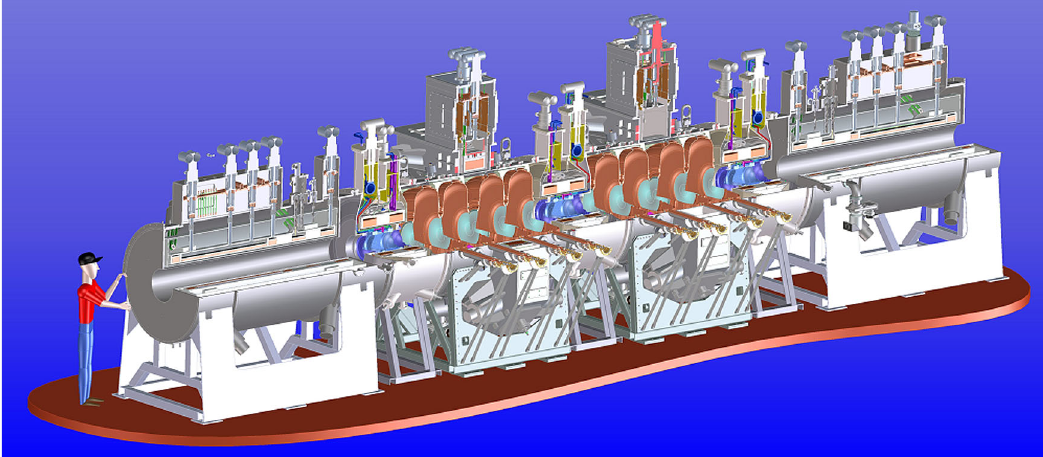
FIG. 11. Engineering drawing of the MICE experiment [14]. The central region shows two ionization cooling cells, with instrumentation regions on either side for measuring the parameters of muons entering and leaving these cells.